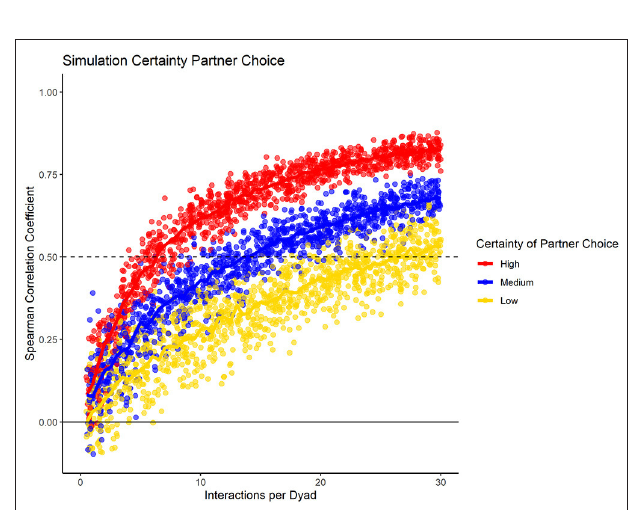
FIGURE 4 | Data simulation of varying fidelity of partner choice, while having consistent group size, data density, and no preference changes throughout the